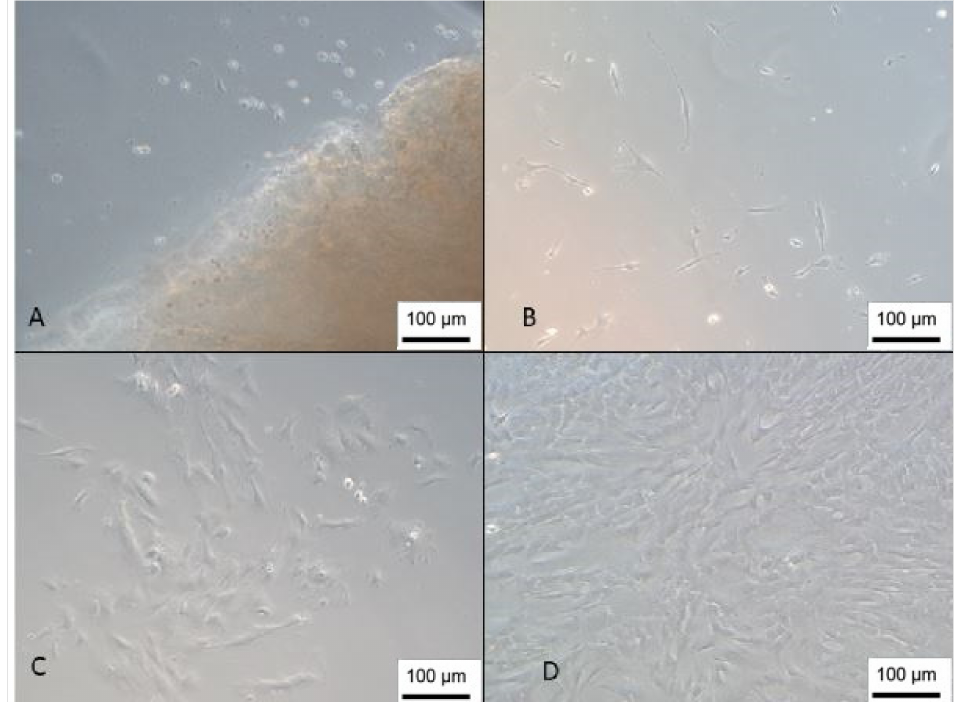
Figure 1. Isolation of the WJ-MSC. ( A ) Cells 1 day after isolation next to a Wharton’s jelly tissue piece; ( B ) day 8; ( C ) day 13; ( D ) cells with 85% confluence (inverted optical microscopy, 100 X). Scale bar, 100 µ